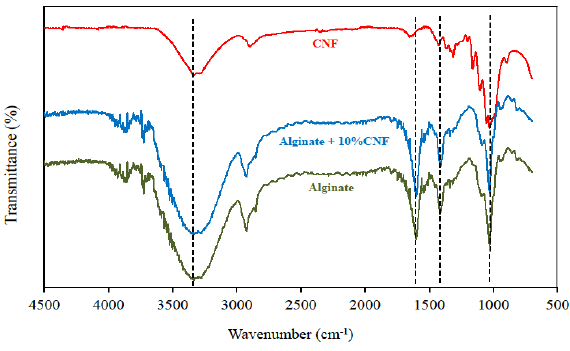
Figure 3. Fourier Transform Infrared (FTIR) spectra of cellulose nanofibrils (CNF), alginate film, alginate with 10 wt % of CNF film.